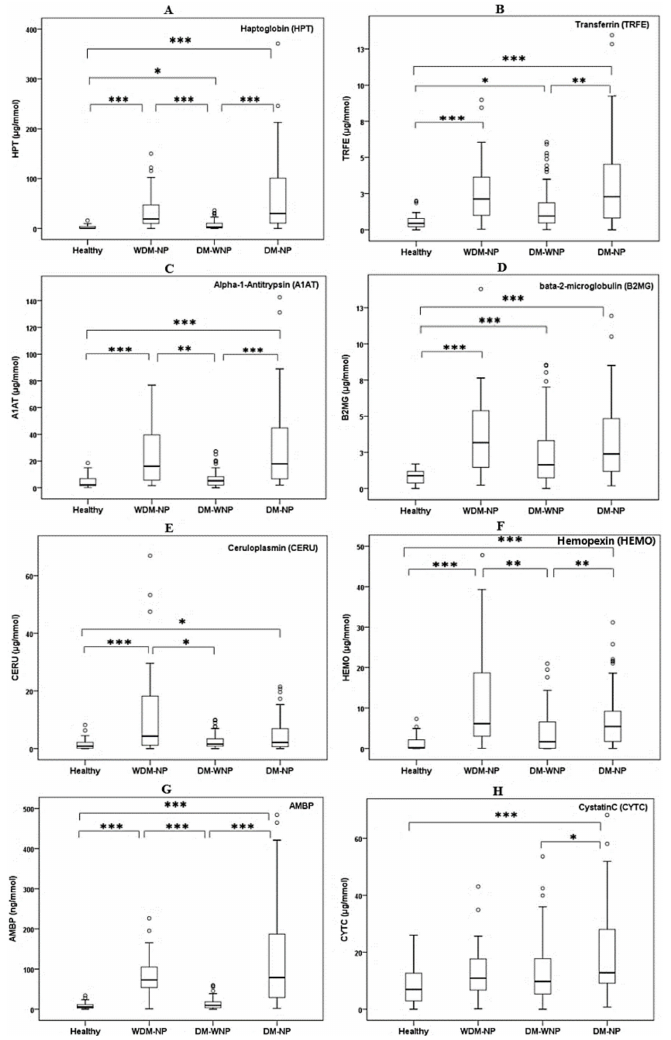
Figure 2. ELISA results for eight urinary protein biomarkers ( A . HPT; B . TRFE; C . A1AT; D . B2MG; E . CERU; F . HEMO; G . AMBP; H . CYTC) in healthy individuals ( n = 34), patients with micro-